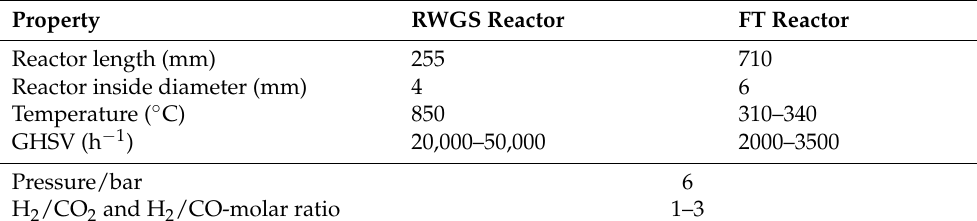
Table 1. Dimensions and reaction conditions of the RWGS and FT